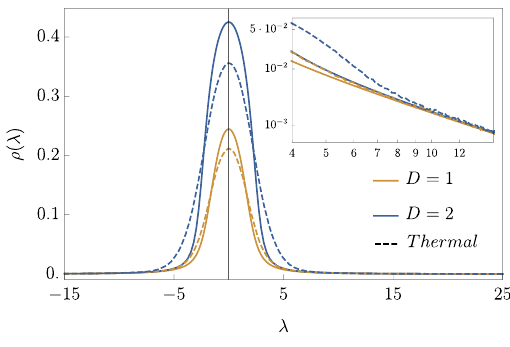
Figure 6: Root density generated in two different quenches (continue lines) com- pared with the thermal state it would be reached in the absence of integrability (dashed lines). More specifically, the system is prepared in a non-interacting ther- ´ = φ | 2 and inverse temperature β = 1 and mal state with Hamiltonian H d x | ∂ t < 0 x densities chosen to be in the strong-interacting regime D = 〈| φ | 2 〉 equal to 1 and 2 respectively. The parameters of the putative thermal states shall be chosen to match the initial value of energy and density. Note that because of the UV divergence of the energy, the final value of β = 1 remains unchanged, while µ is adjusted to match the initial densities. Inset: tails of the roots in logarithmic scale, which besides of collapsing on the same curve they also agree with the initial thermal distribution, as we explain in the main